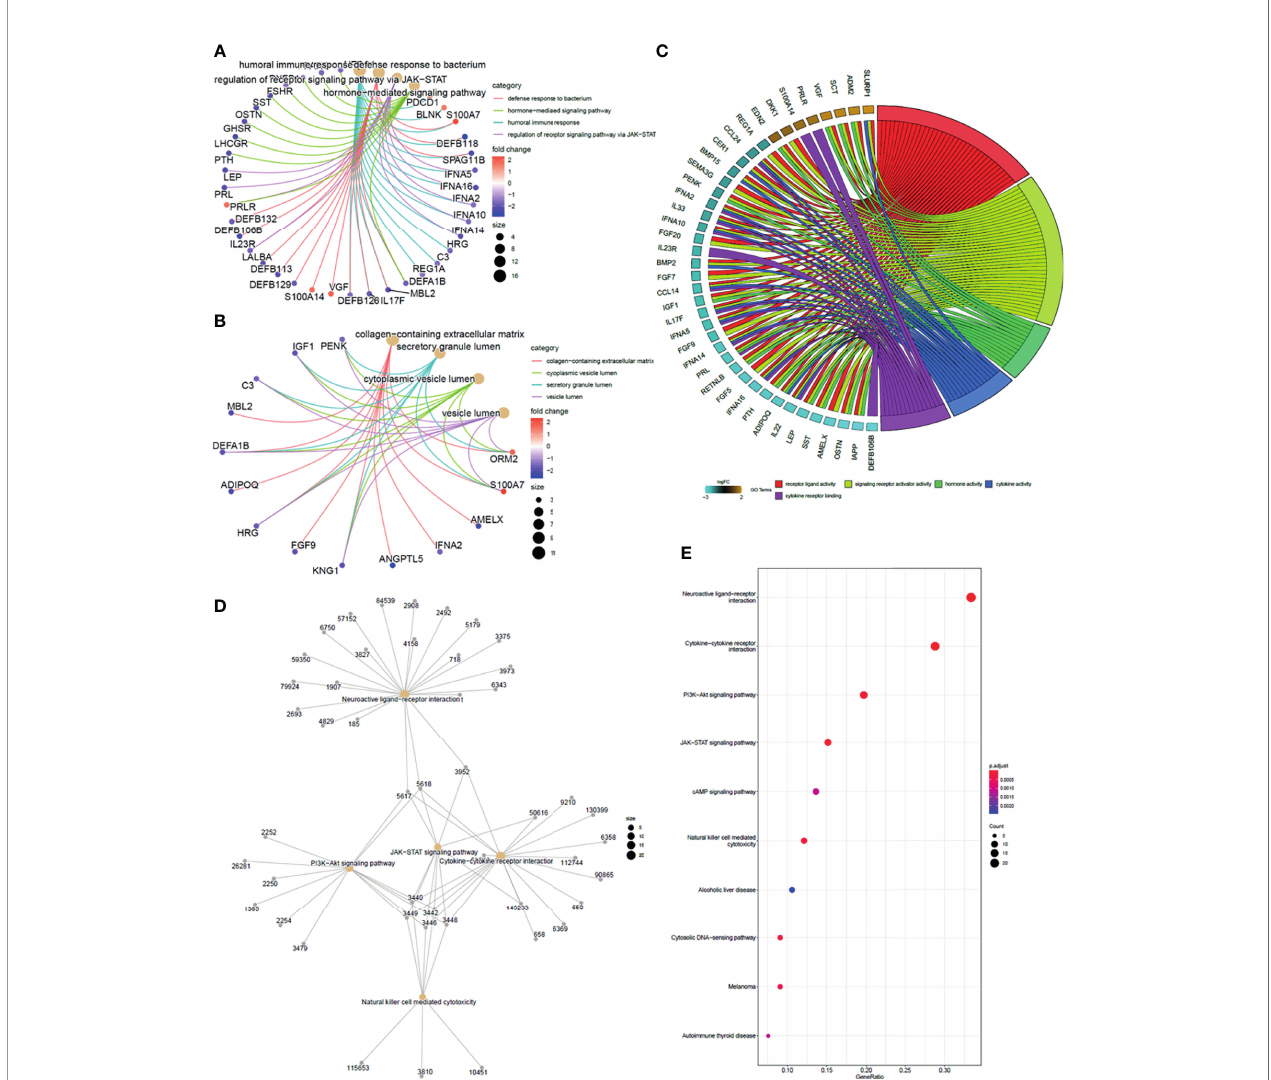
FIGURE 4 | Function enrichment analysis of overlapping DEGs. (A) GO cluster plot showing a chord pro fi le circle of biological processes (BP) of the expression spectrum. (B) GO cluster plot showing a chord pro fi le circle of cellular components (CC). (C) GO cluster plot showing a chord dendrogram of molecular functions (MF) of the expression spectrum. (D) KEGG pathway enrichment network. The nodes represent the signi fi cantly enriched genes on the speci fi c signaling pathway. (E) The y - axis is the KEGG pathway enriched terms, and the x -axis is the fold of enrichment. The size of the dot means the abundance of enriched genes under the